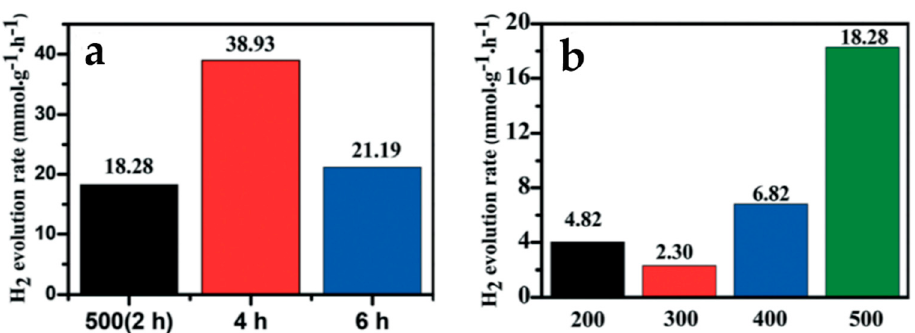
Figure 18. ( a ) Comparison of hydrogen evolution rates for Zn 0.67 Cd 0.33 S solid-solution nanosheets with a varying sulfurization temperature [62]. Reprinted with permission from ref. [62]. ( b ) The comparison of the hydrogen evolution rates for ZnO/Zn x Cd 1 − x S for varying oxidation times [62]. Reprinted with permission from ref. [62].